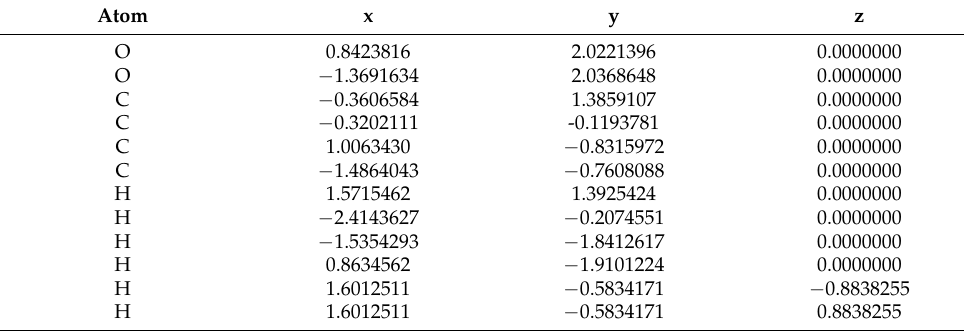
Table A2. Optimized geometry of the cis-ring (CR) conformer.